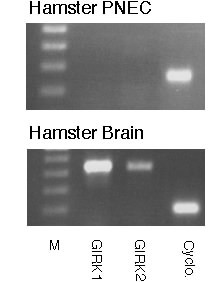
Lack of GIRK1 and 2 expression in hamster PNEC cells. Top panel: Pulmonary neuroendocrine cells were isolated from fetal hamsters on the 15th day of gestation. Neither GIRK1 nor GIRK2 was expressed in normal PNEC. Bottom panel: Tissue was isolated from adult hamster brain to determine if the lack of expression in PNEC was not due to species differences in PCR primers. Both GIRK1 and GIRK2 were expressed in hamster brain. Cyclophilin, used as a positive reaction control was seen in the samples. For all gene expression experiments, negative control reactions were performed and found to be negative. The bands on the agarose gels were consistent with the expected sizes: GIRK1-441 bp; GIRK2-438 bp; cyclophilin-216 bp, M-100 bp.